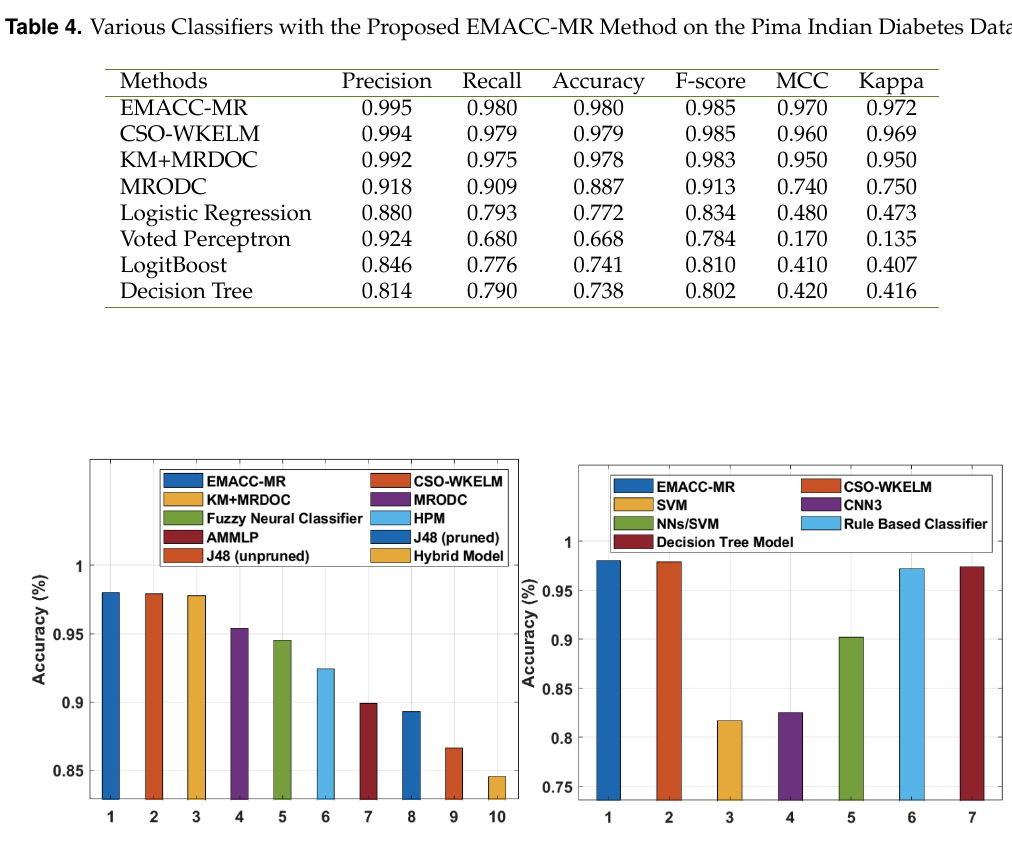
Fig. 5. (a) Accuracy analysis of the EMACC-MR method on the Pima Indian diabetes dataset with distinct, (b) Accuracy analysis of the EMACC-MR method on the activity recognition dataset with distinct